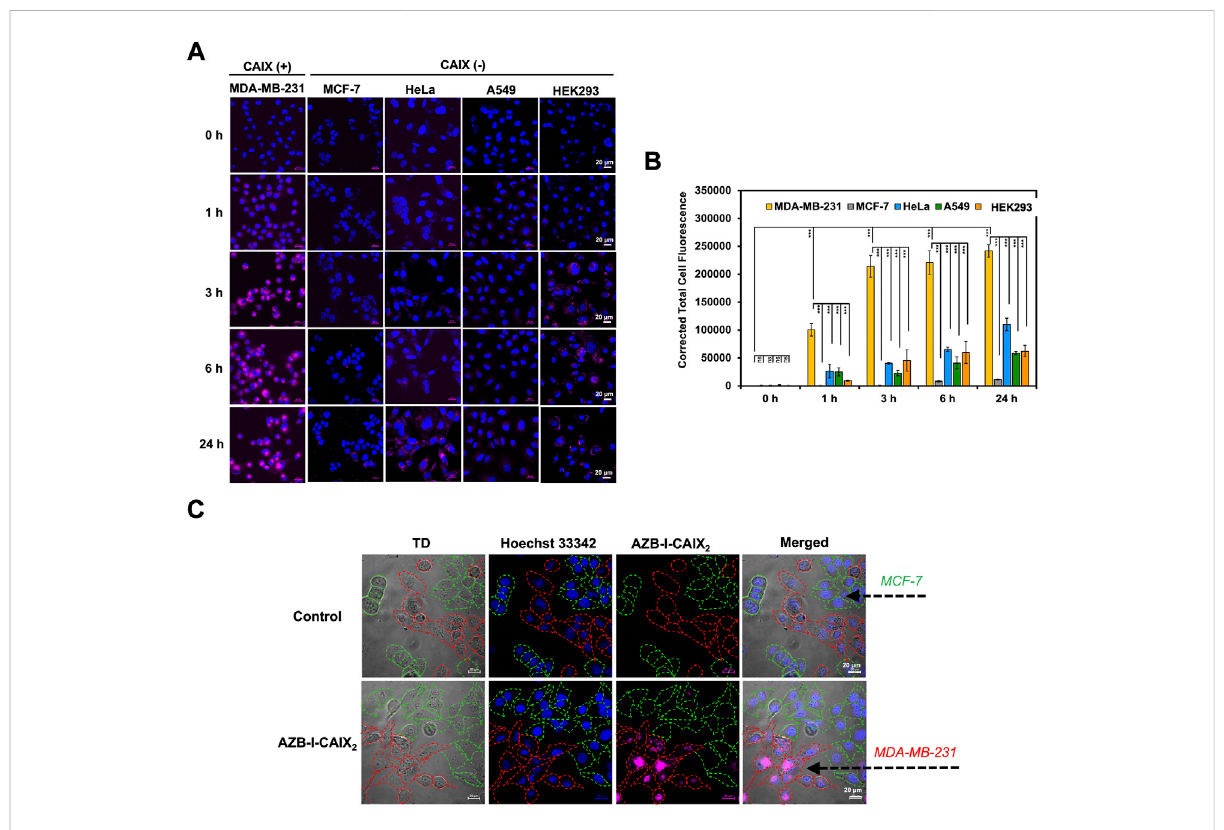
Selective CAIX-dependent uptake of AZB-I-CAIX 2 on various cells. (A) Time-dependent cell internalization of AZB-I-CAIX 2 tested on CAIX+ (MDA-MB-231) and CAIX- (MCF-7, HeLa, A549, HEK293) cells. (B) Corrected Total Cell Fluorescence (CTCF) of signals from experiment (A) (C) Confocal images of AZB-I-CAIX 2 internalized CAIX+ (MDA-MB-231) and CAIX- (MCF-7) in the co-culture system. Statistical analysis: One-way ANOVA followed by Tukey ’ s analysis was used for comparison between multiple groups using GraphPad Prism9 software. p values of less